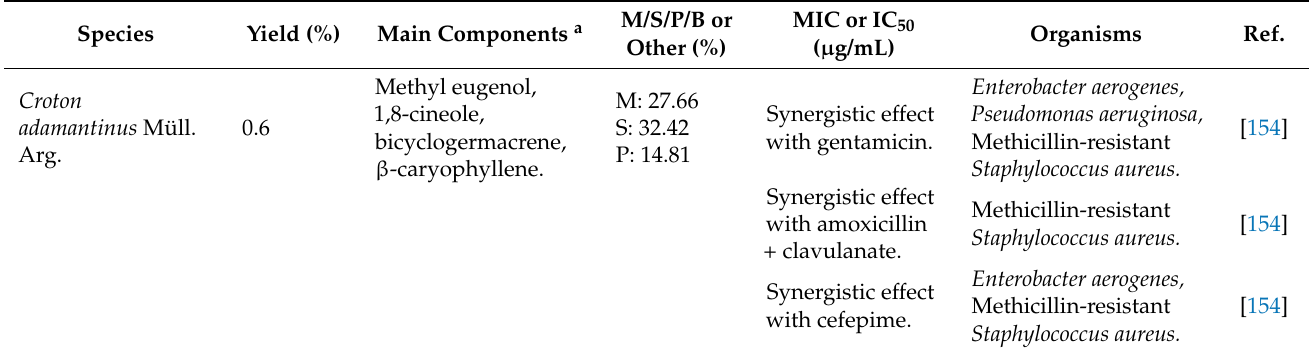
Table 10. Summary of antimicrobial activity of Croton spp. essential